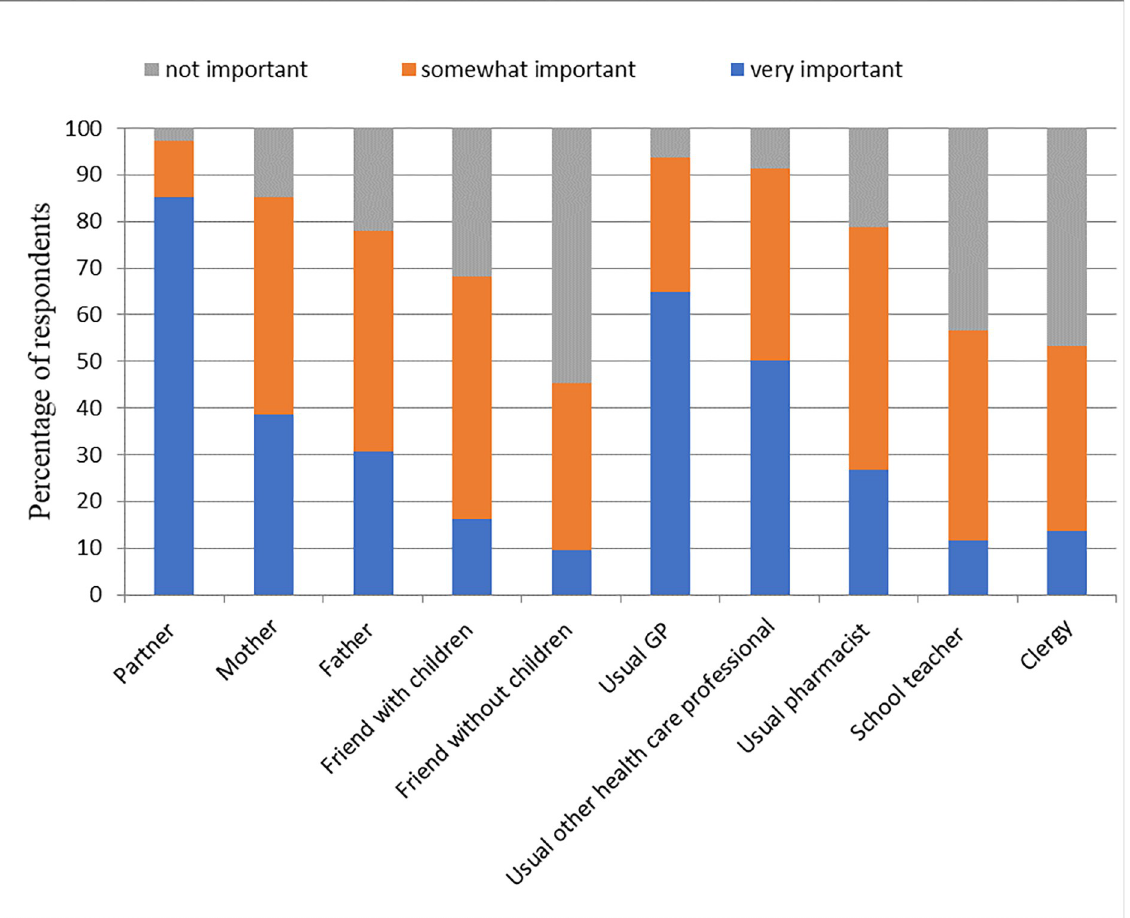
Fig 3. Importance of key influencer views on respondent decision to